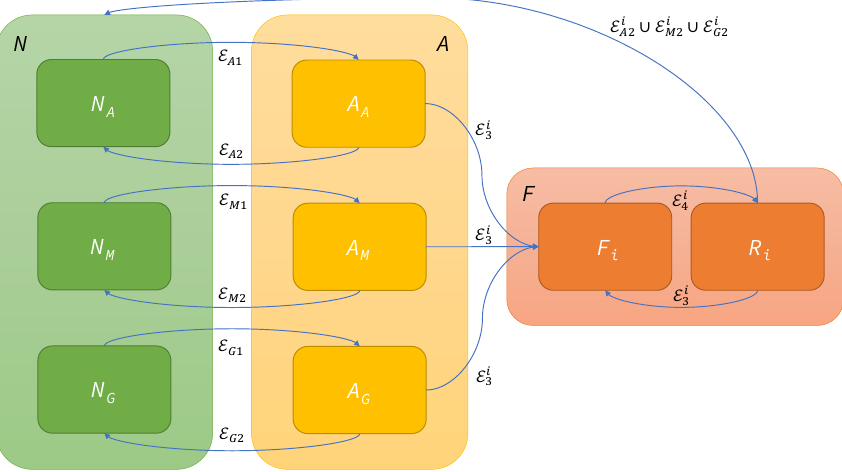
Figure 4. State transition graph for SFDI. Normal state (green) N = N A ∩ N M ∩ N G , alert state (yellow) A = A A ∩ A M ∩ A G , fault state (red) F = driven state